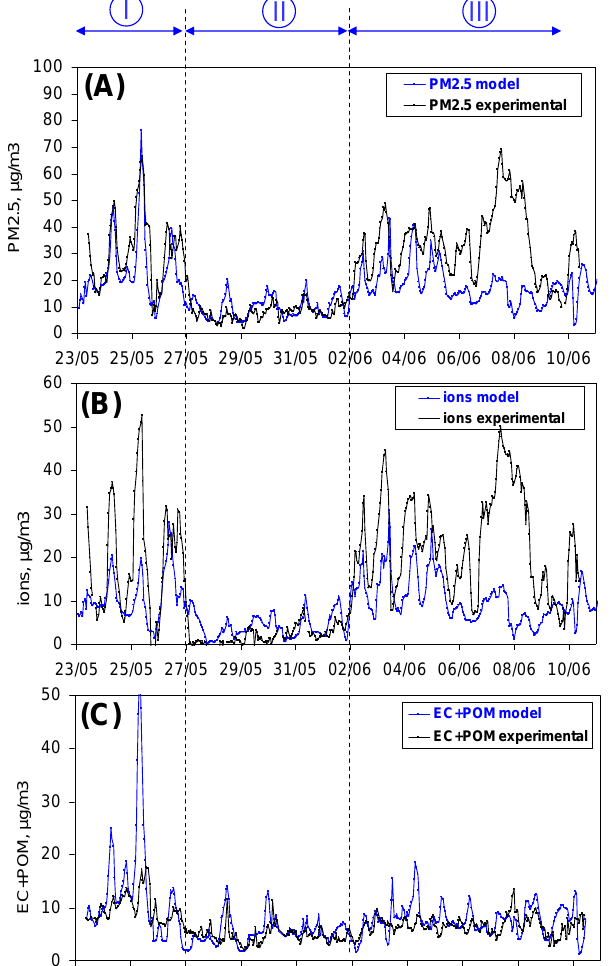
Fig. 9. Comparison between modeled and measured concentrations of PM 2 . 5 (A) , ion species (ammonium nitrate + ammonium sulfate) (B) , and carbonaceous matter (EC+POM) (C) . Periods noted I, II, and III correspond to those reported in Sect. 4.1.